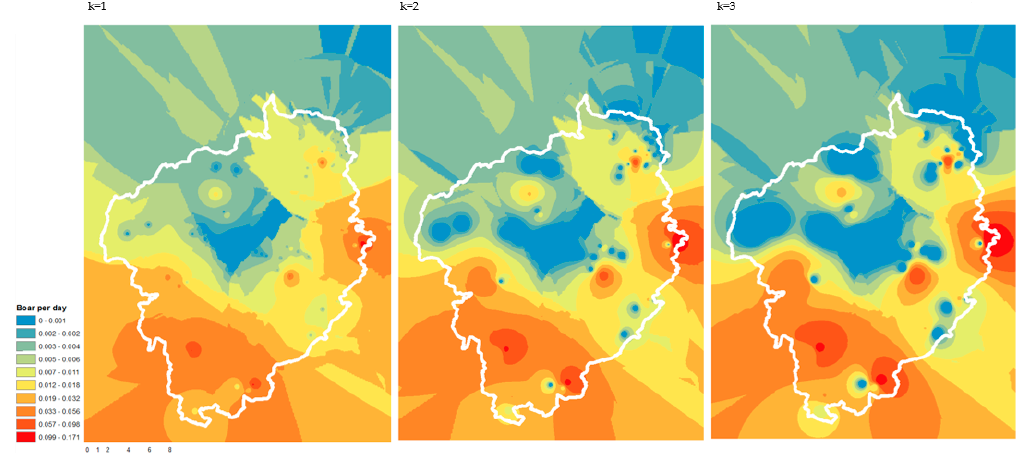
Figure 2. IDW interpolated boar density by k